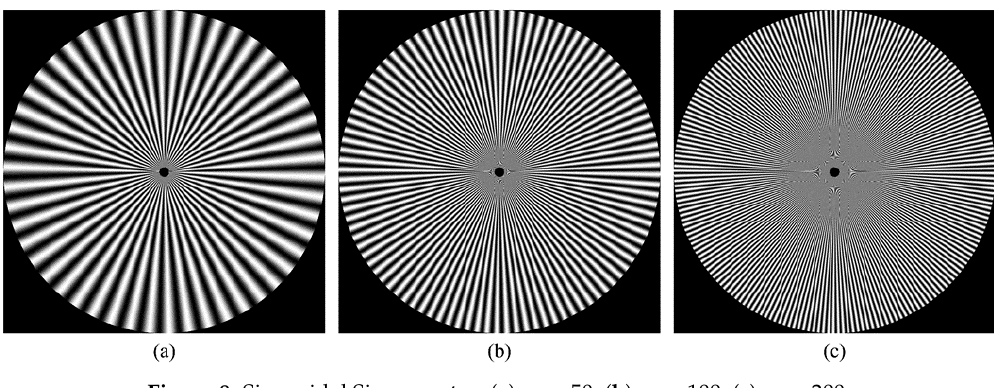
Figure 8. Sinusoidal Siemens star: ( a ) ω = 50, ( b ) ω = 100, ( c ) ω = 200.